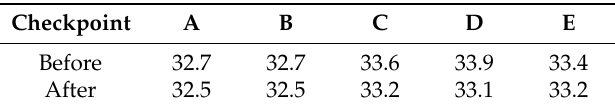
Figure 14. Ex S.I.M.E.—Temperature cross-section tomographies. Before intervention at the top, after intervention on the bottom (see Table 1). Table 1. Ex S.I.M.E.—Temperature (°C) before and after.